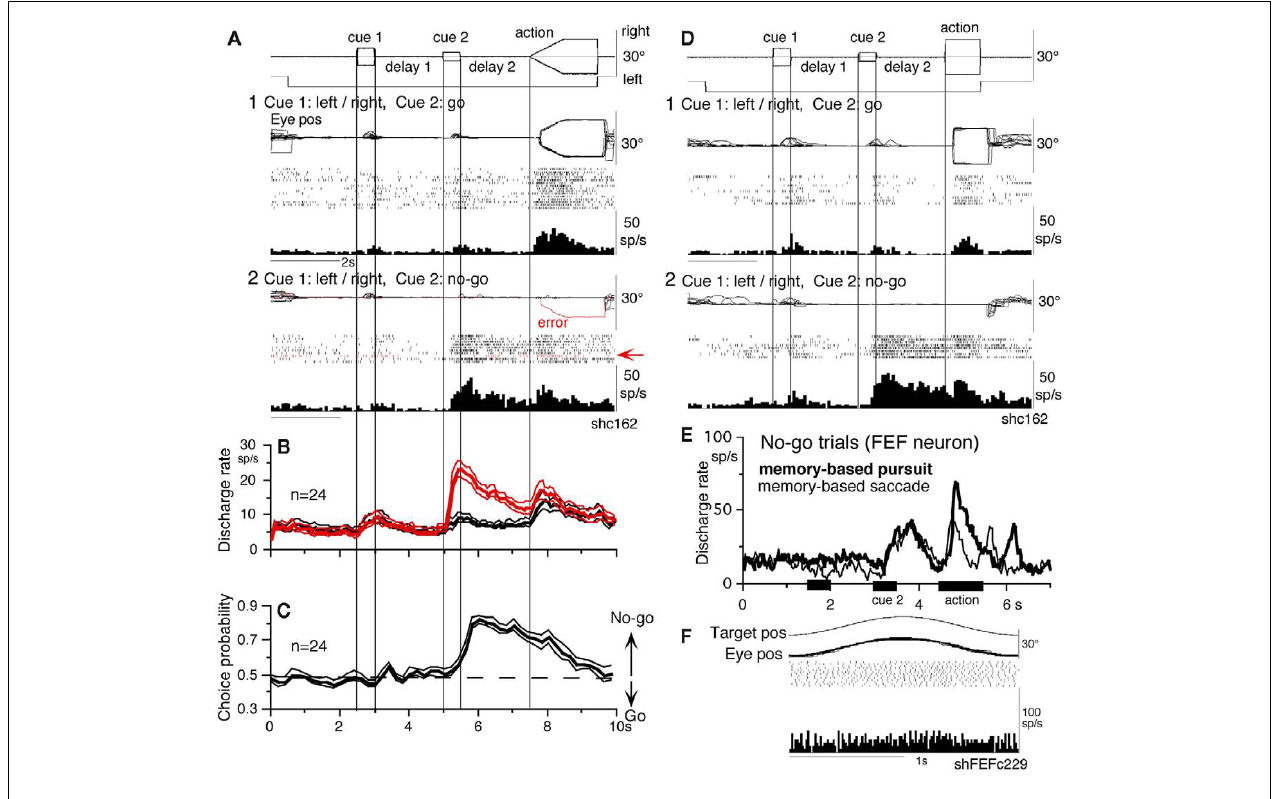
neurons during no-go and go trials. (D1,D2) Go and no-go trials during memory-based saccades, respectively. (E,F) Discharge of a representative FEF no-go neuron during no-go trials of memory-based pursuit [ (E) , thick] and memory-based saccades [ (E) , thin]. (F) Simple pursuit of a single spot that moved sinusoidally. None of no-go neurons responded during simple pursuit of a single spot. (A–D) Reproduced from Shichinohe et al. (2009) with permission. (E–F) Reproduced from Fukushima et al. (2011a) with